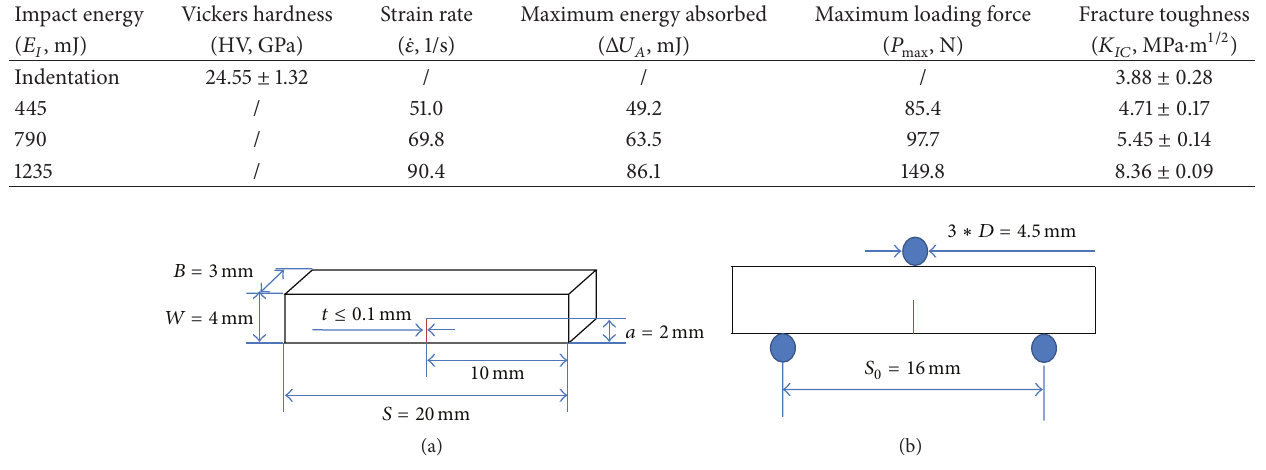
Figure 4: (a) Schematic of the ceramic specimen; (b) fixture configuration of the three-point loading.